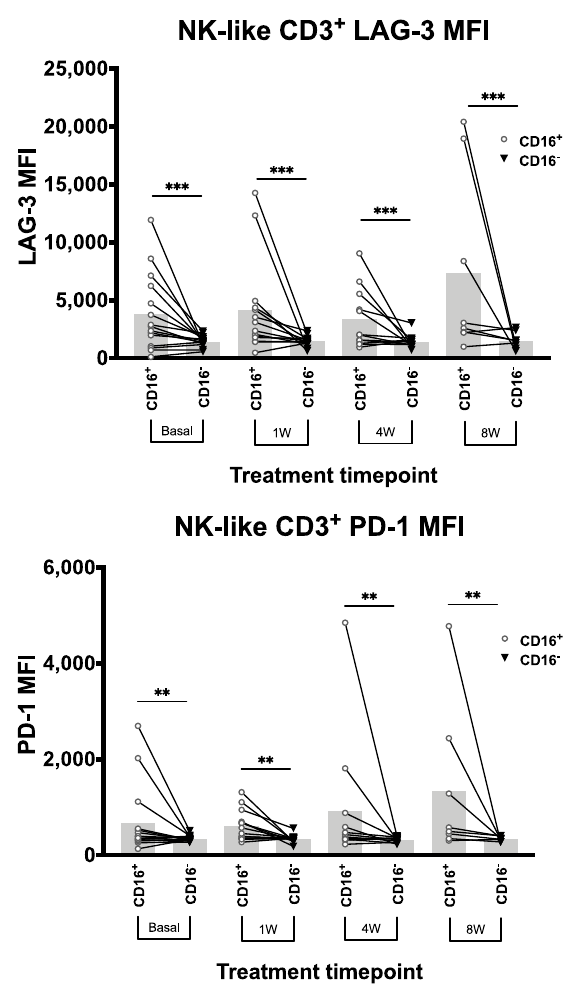
Figure 2. PD-1 and LAG-3 cluster with CD16 in NK-like CD3 + cells of patients developing eDAEs. LAG-3 ( top ) and PD-1 ( bottom ) Mean Fluorescence Intensity (MFI) quantification in NK-like CD3 + cells with and without CD16 expression (CD16 + and CD16 − respectively) at baseline and 1, 4, and 8 weeks ( n = 15). Bar height represents the mean of each group. MFI: Mean Fluorescence Intensity. **: p < 0.01, ***: p < 0.005.